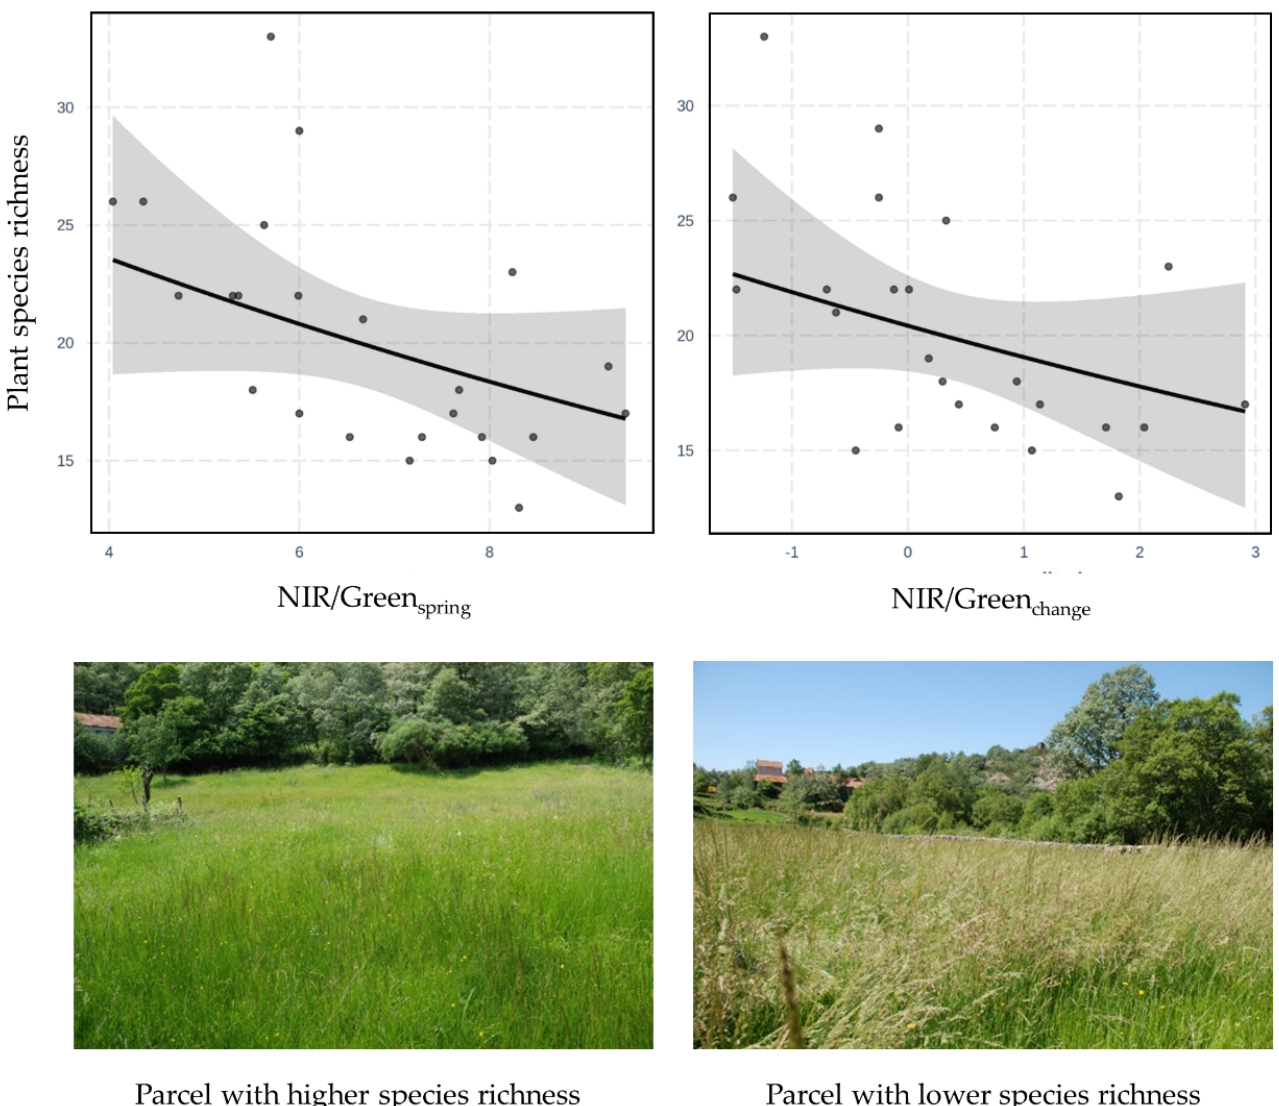
Figure 5. Relationship between plant species richness and the set of predictor variables composing the most supported spatial pathway (AIC ≤ 2) to monitor species richness in the grassland parcels ( n = 24) of Peneda-Ger ê s, Portugal (lines, fitted estimates; shading, 95% confidence levels). NIR/Green spring is the near-infrared green simple ratio estimated from the spring Sentinel-2 satellite scene. Table 2. Predictive performance of the most supported spatial pathway ( ∆ AICc ≤ 2.0) for the prediction of plant species richness in grassland parcels evaluated using a leave-one-out cross- validation approach. The units of root-mean-square error (RMSE) and mean absolute error (MAE) are plant species richness